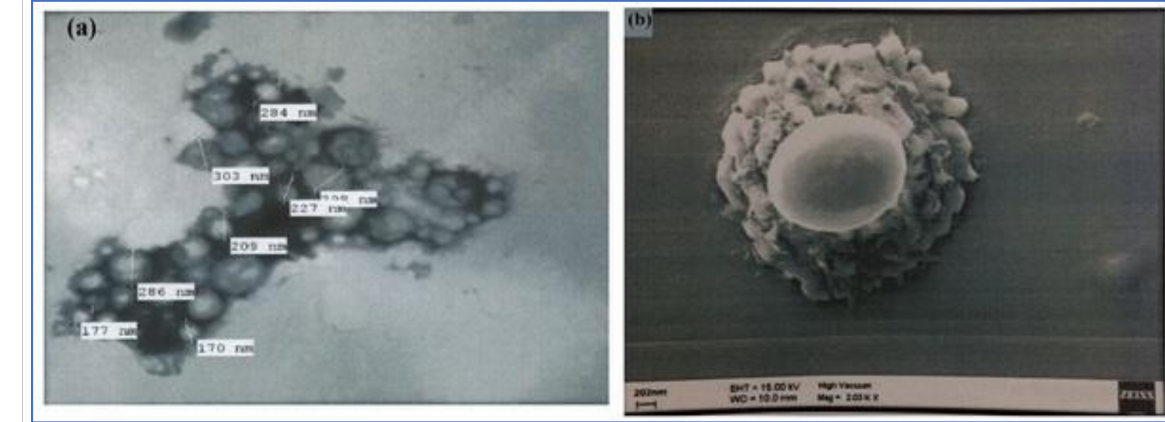
Figure 4. (a ) TEM image of BNPs ( b ) SEM image of BNPs.